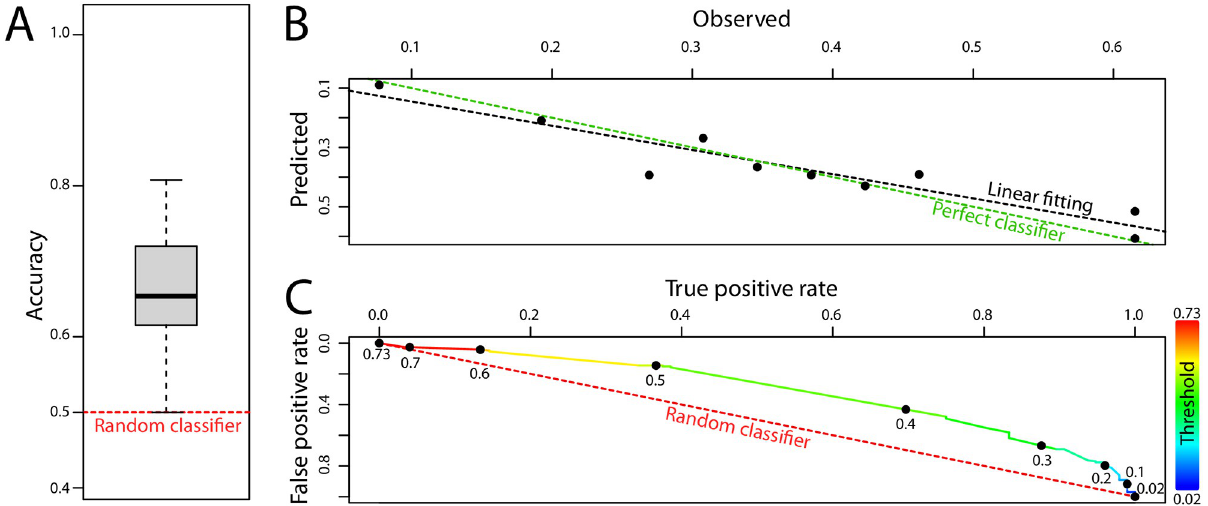
Fig 5. A: Box plot of the accuracy of the logistic model . The accuracy, measured as the fraction of correctly predicted spillover risk, is 0.657 ± 0.07. In the plot the wide black line indicates the median. The box delimits the (25%, 75%) percentile interval, and the whiskers represent the minimum and maximum values (no outliers were present in this case). The accuracy analysis was performed repeating a 10-fold cross validation three times (see text). B: Predicted versus observed spillover risk scores . The green dotted line is the expected behavior of a perfect classifier and the circles represent the results obtained from our model (see text). The black dotted line is the linear fitting of the points. C: ROC curve . As a function of the classifier threshold (color scale) the true versus false positive rate is plotted. The model deviates clearly from a random classifier (red dotted line). Analyses with a threshold larger/smaller than 0.73/0.02 accumulate in top left/bottom right corner of the